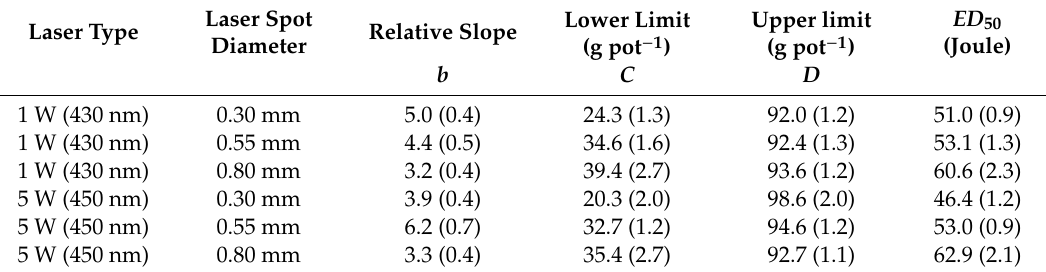
Table 2. Estimated parameter and standard errors (SE) of the dose-response models (model 3) for experiments with two laser types and three intervals of internal laser spot diameter corresponding to the curves in Figure 15. The parameter ED 50 is the e ff ective dose (energy in Joule) required to reduce the biomass by 50% between D and C. The parameter b is proportional to the slope at dose x equal to the parameter ED 50 .